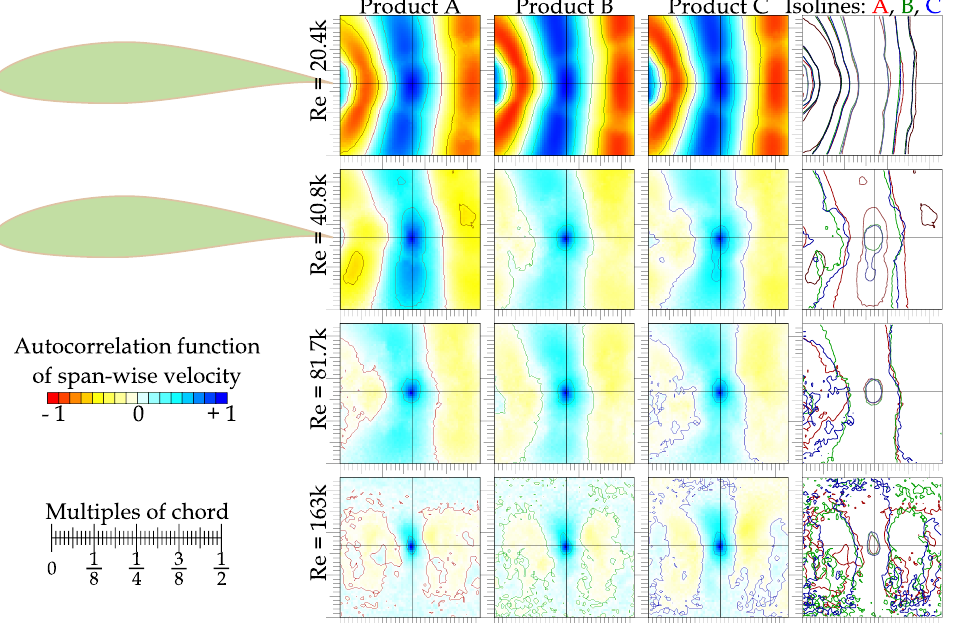
Figure 17. Autocorrelation function of cross-stream velocity component v with a reference point in the middle of the field of view; i.e., 0.21 c past the trailing edge at α = 0 ◦